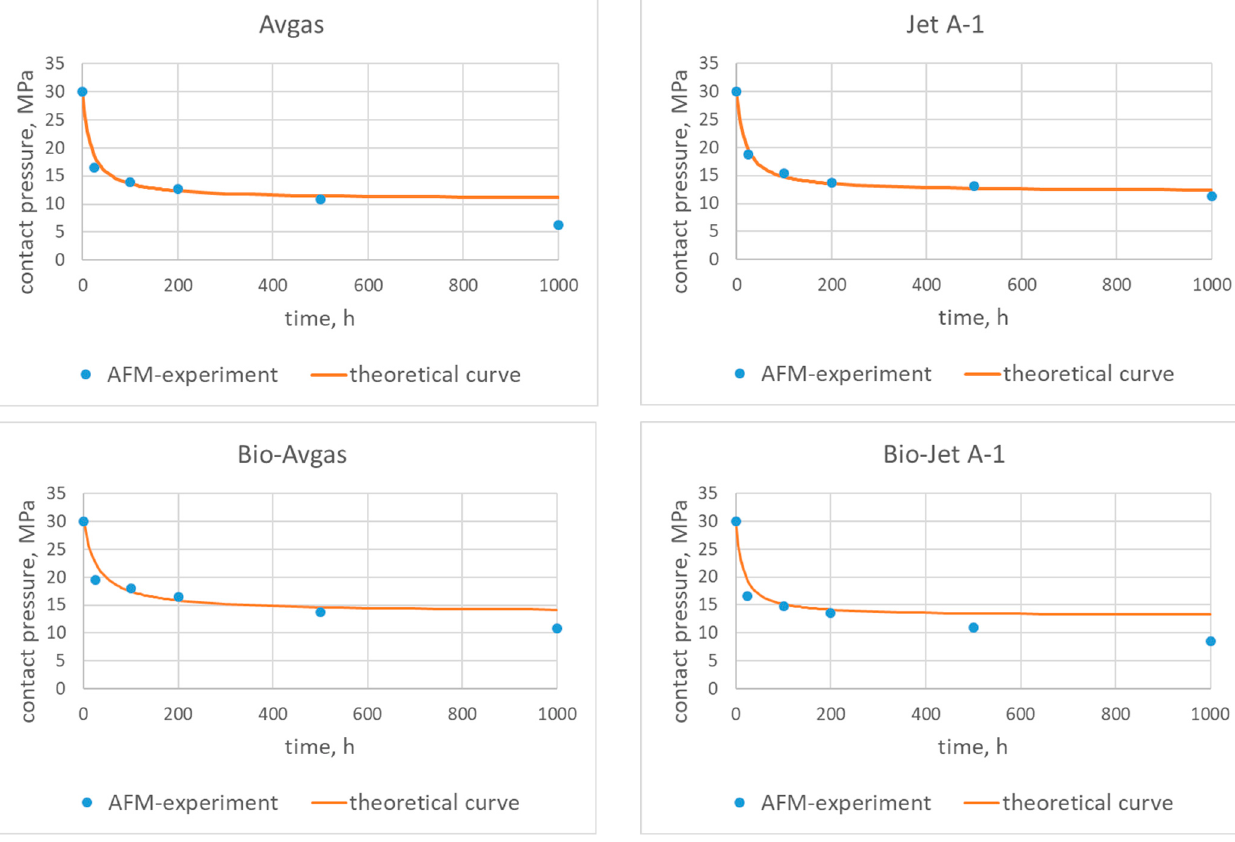
Figure 6. Contact pressure for the AFM gasket and the tested fuels—theoretical characteristics and experimental data.